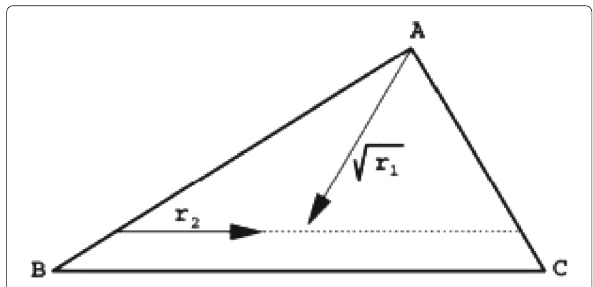
Fig. 14 Random selection of a point in a triangle after triangulation of 3D model [21]. r 1 and r 2 are two random numbers ∈ [0,1] which sets the percentage distance from vertices A and B , and P is the point (Eq.